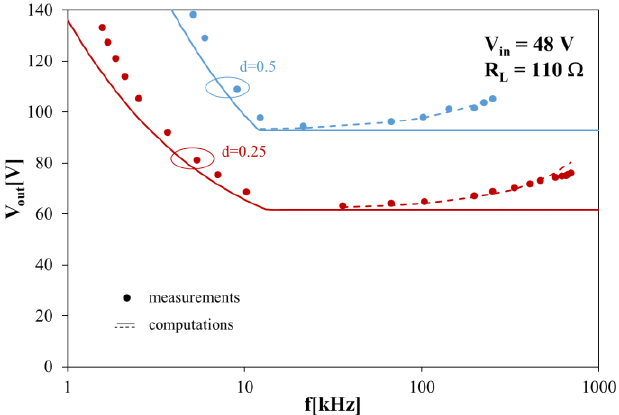
Figure 14. Measured and computed dependences of the output voltage on frequency.